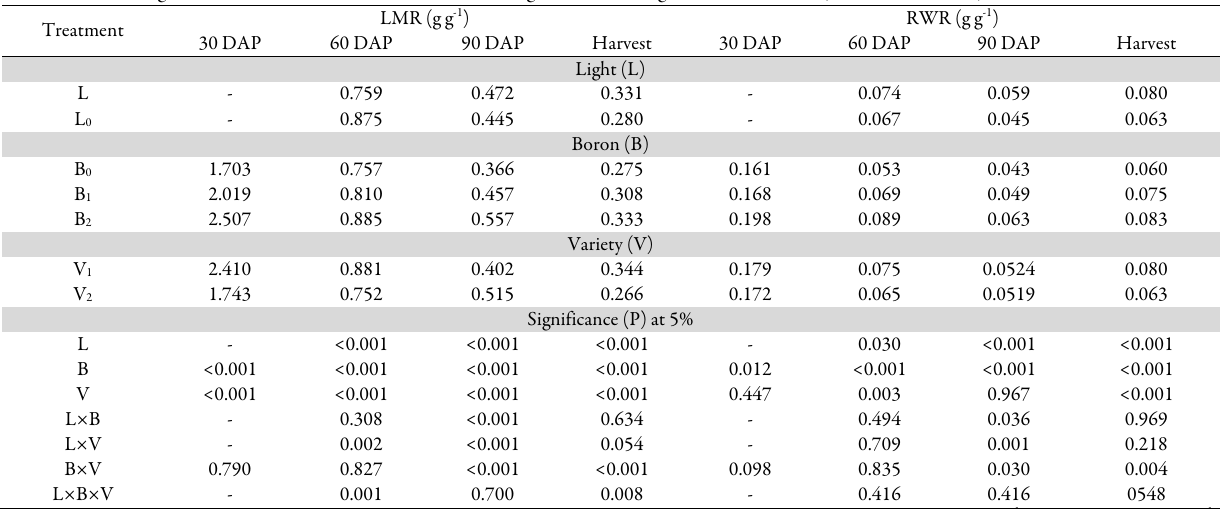
Table 4. Effect of light and boron on leaf mass ratio and root weight ratio of two groundnut varieties (Mean of two trails) Treatment